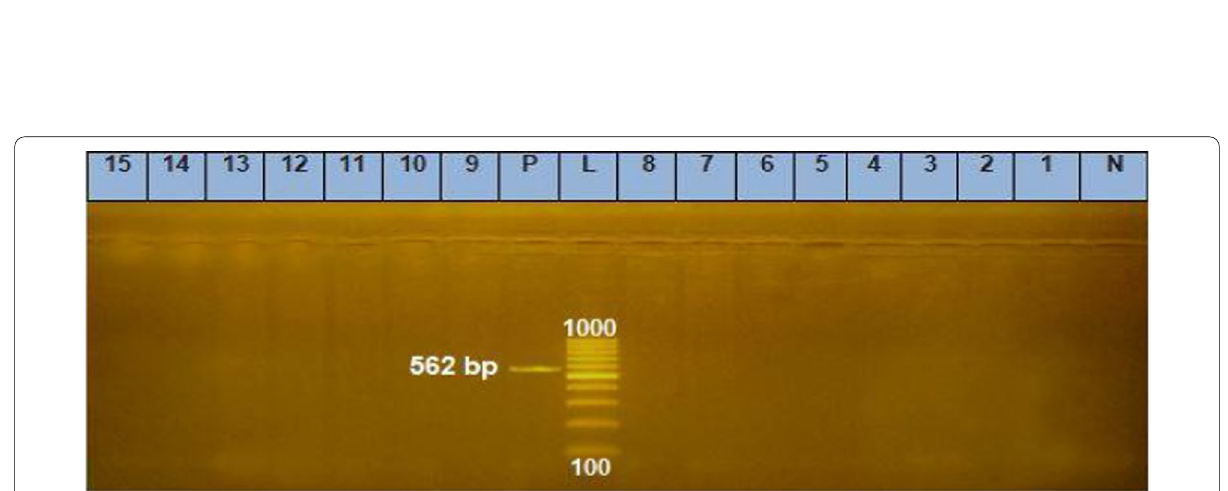
Fig. 10 Agarose gel electrophoresis showing amplification product of 562 bp of qnrB . Lane L : Ladder (Marker) 100‑1000 bp plus DNA ladder. Lane P : control positive. Lane N : control negative. Lane 1–15 : examined